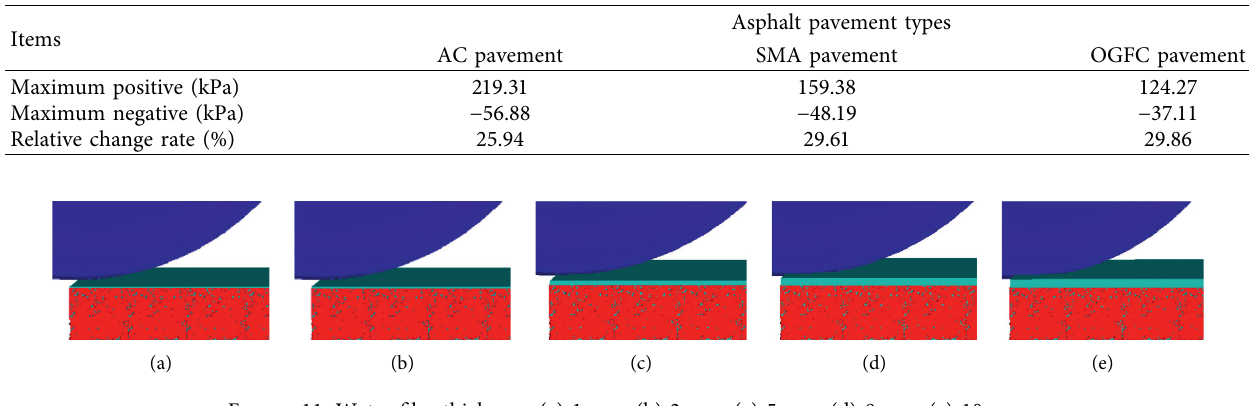
Table 4: Peak values of pore water pressure in pavement structure.